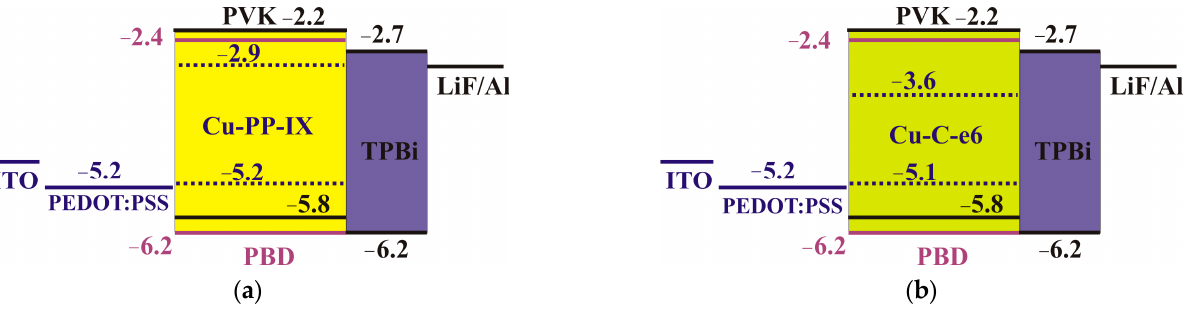
Figure 8. Energy diagram for the OLEDs involving ( a ) Cu PP IX and ( b ) Cu ‐ C ‐ e6. Energy levels for PVK [13], PEDOT:PSS [19], PBD [19], and TPBi [20] are from the literature.